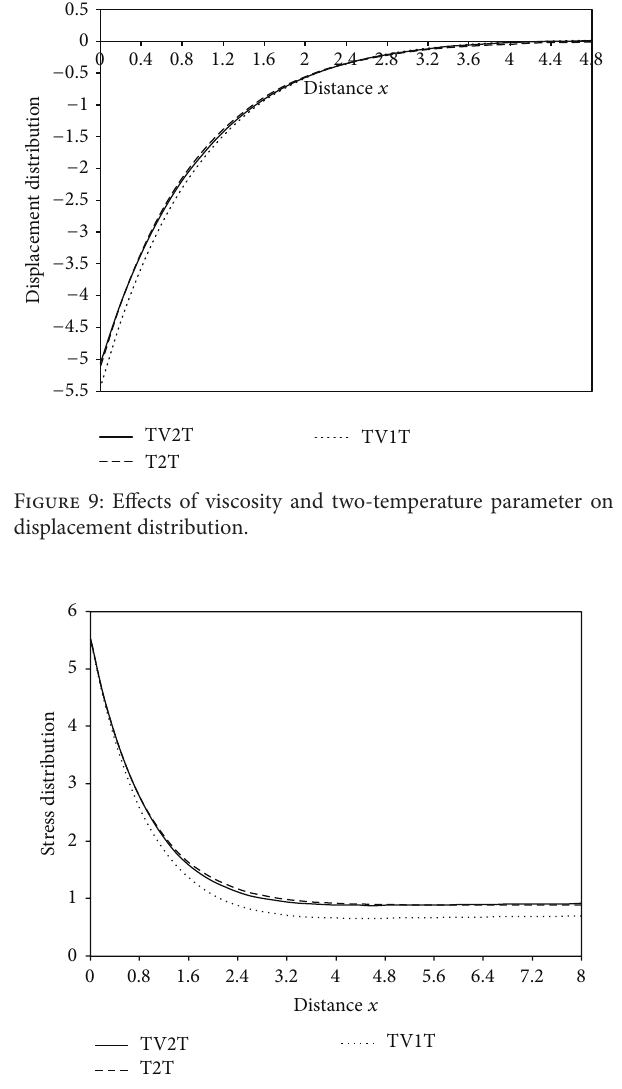
Figure 10: Effects of viscosity and two-temperature parameter on stress